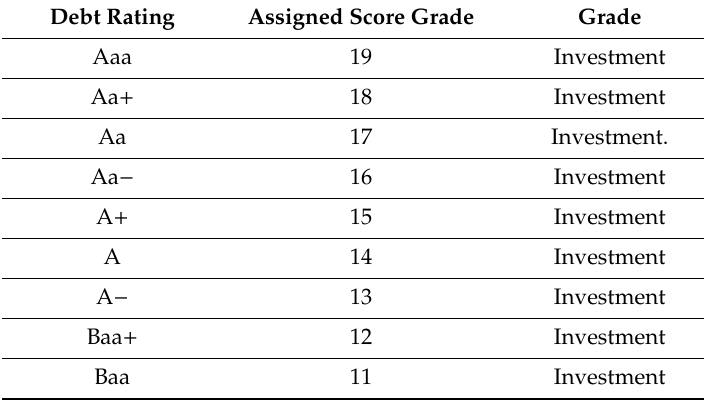
Table 2. Credit rating scale and